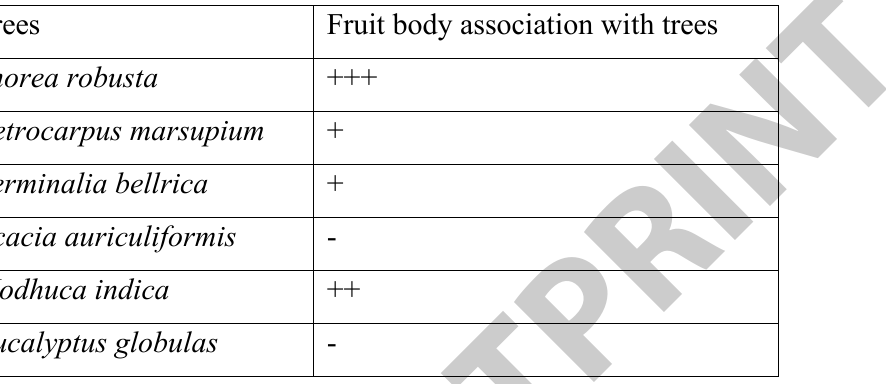
Table 3 Association of Astraeus asiaticus with different trees.